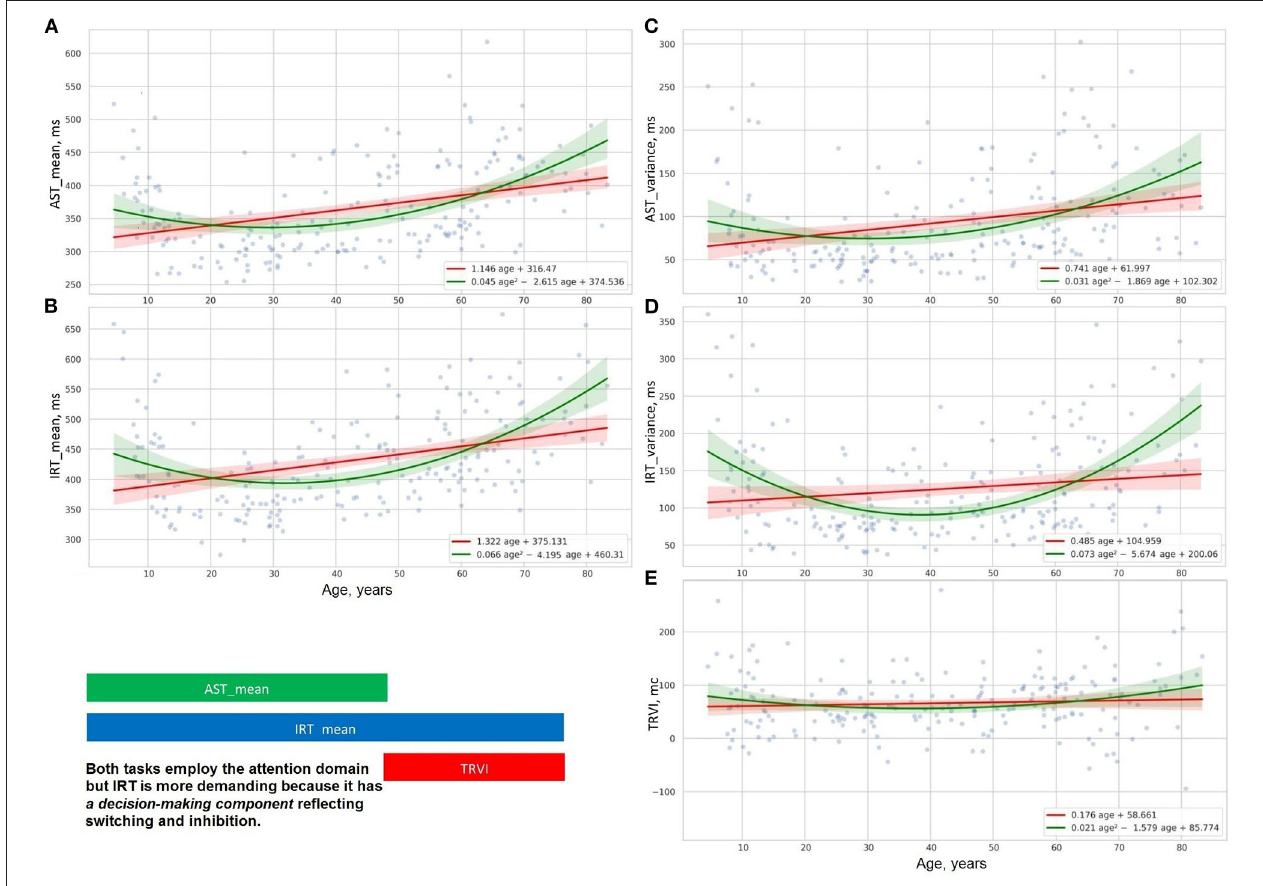
FIGURE 6 | Distribution of time delay because of distraction (E) , reaction time and its variance in studies of attention with (B,D) , and without interference (A,C) .